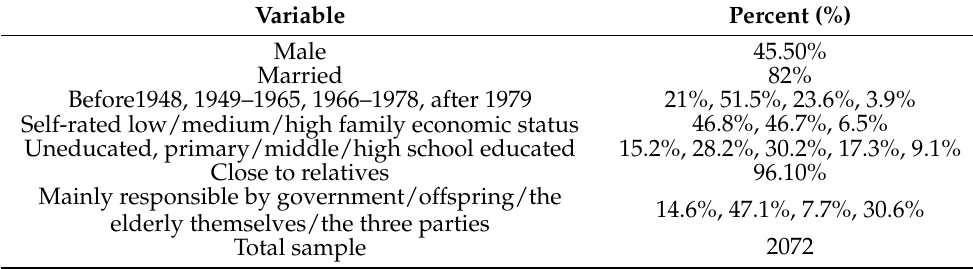
Table 3. The Sample